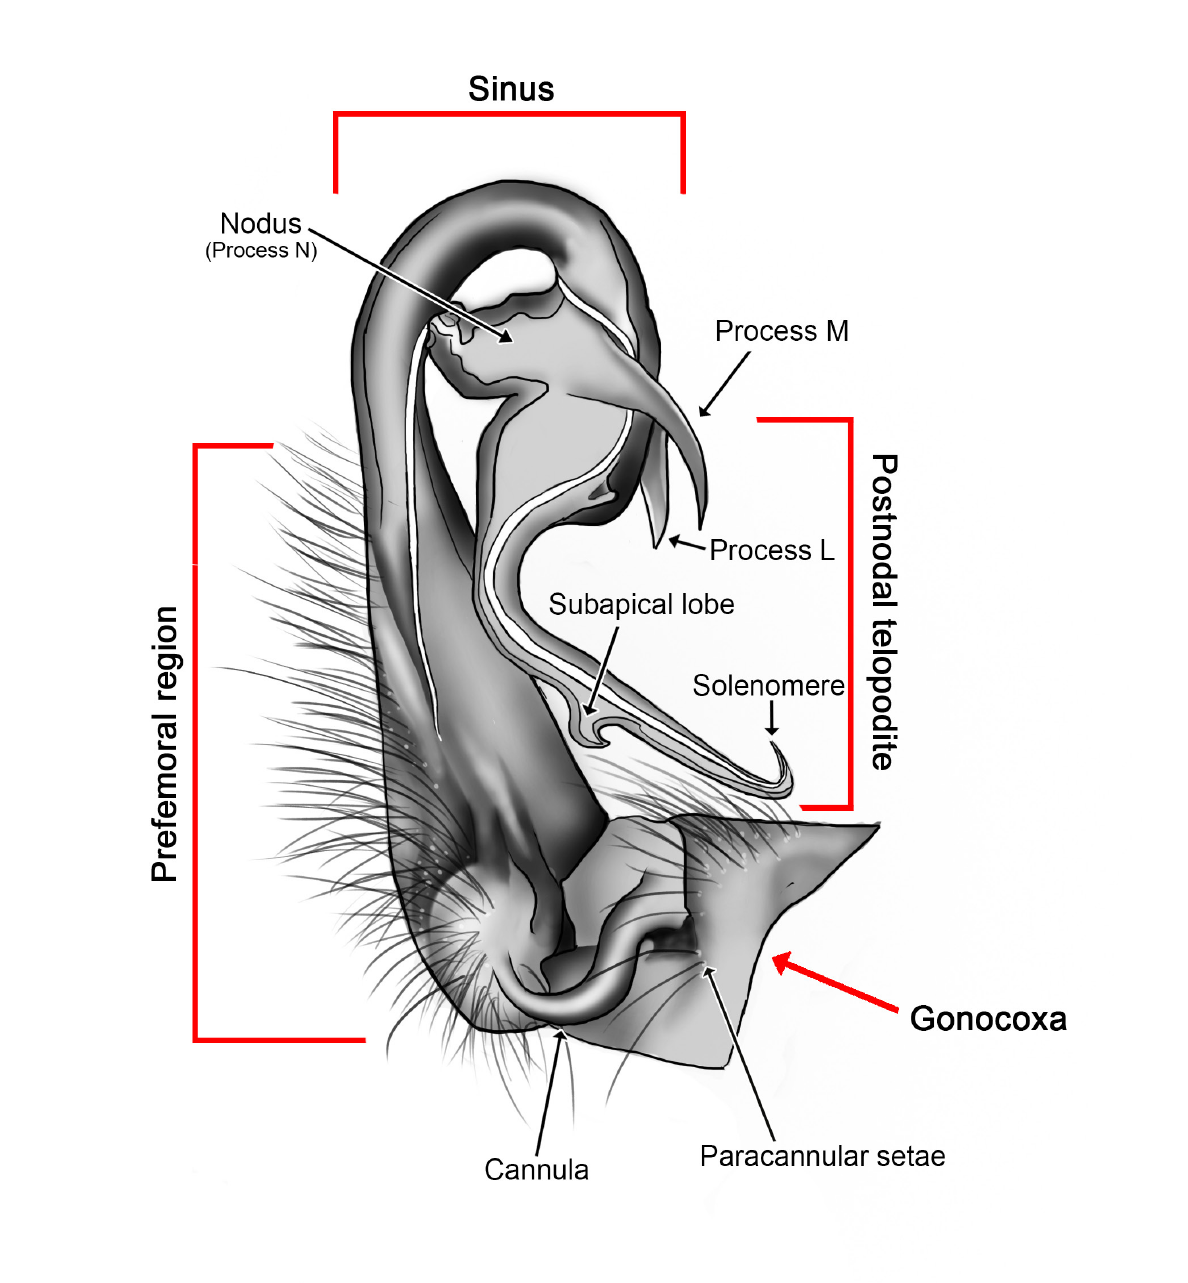
Fig. 3. Right gonopod of Pogoro alopias Rosenmejer & Enghoff sp. nov., mesal view, showing gonopod terminology. Not to